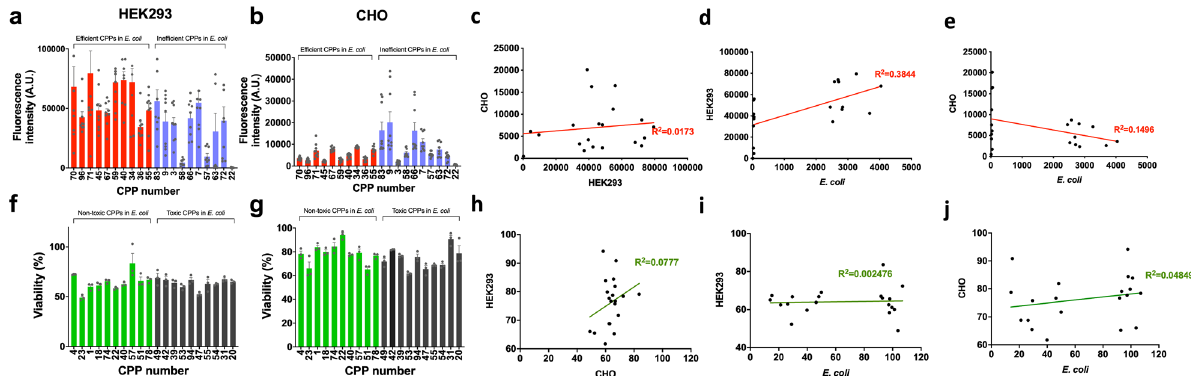
Fig. 8 Penetration ef fi ciencies and cytotoxic effects of the CPPs in HEK293 and CHO cells, and comparison of CPP effects in different cell types. a , b Ten highly ef fi cient CPPs and ten highly inef fi cient CPPs in E. coli were selected, and their cell penetration ef fi ciency was measured in HEK293 and CHO cells ( n = 9). c – e Linear correlations of the penetration ef fi ciencies among the three cell types. f , g Ten highly toxic CPPs and ten highly safe CPPs in E. coli were selected, and their cytotoxicity was measured in HEK293 and CHO cells ( n = 3). h – j Linear correlations of the cytotoxicity among the three cell types. The datasets used to draw the graphs are compiled in Supplementary